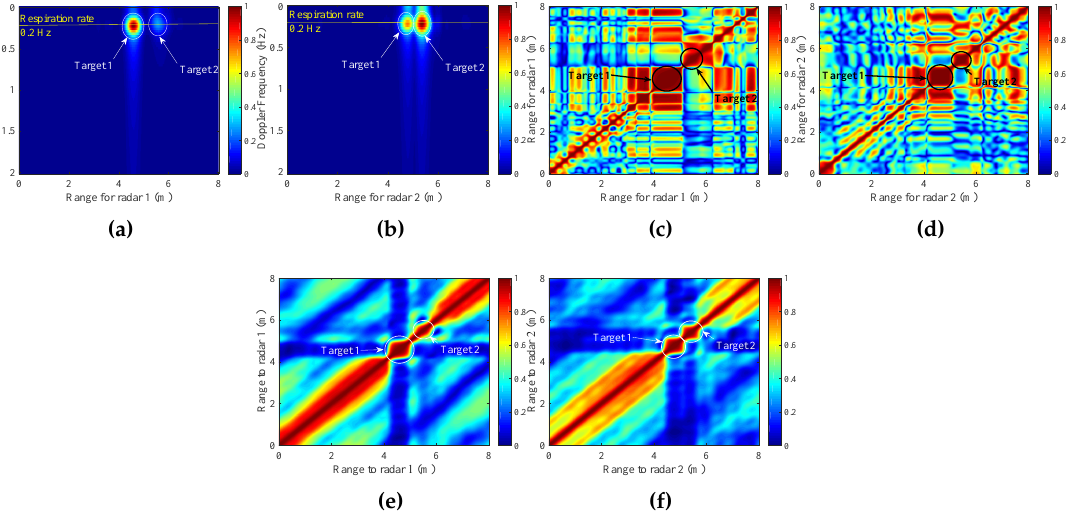
Figure 7. Comparison results of Experiment 1.1: ( a ) RD plane of Figure 6e; ( b ) RD plane of Figure 6f; ( c ) single-radar correlation result of Figure 6e; ( d ) single-radar correlation result of Figure 6f; ( e ) single-radar correlation result of Figure 6a; and ( f ) single-radar correlation result of Figure